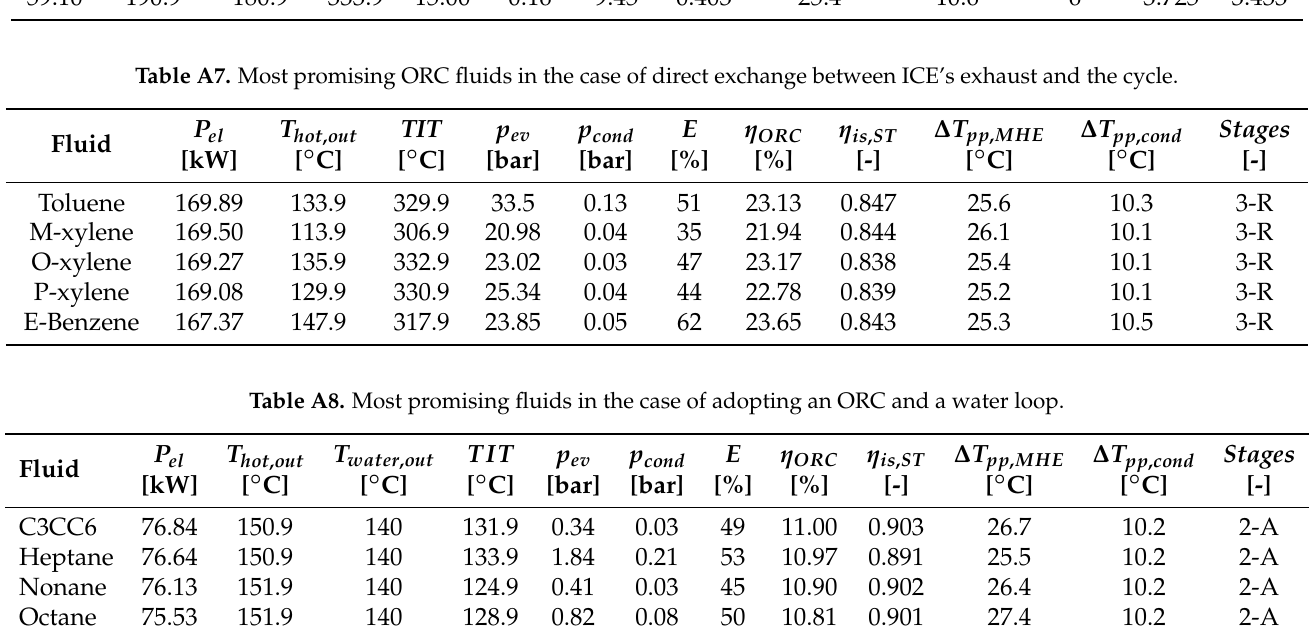
Table A6. Results of the thermodynamic optimization and economic analysis of the SRC adopting an oil thermal loop. P el T hot , out [kW]